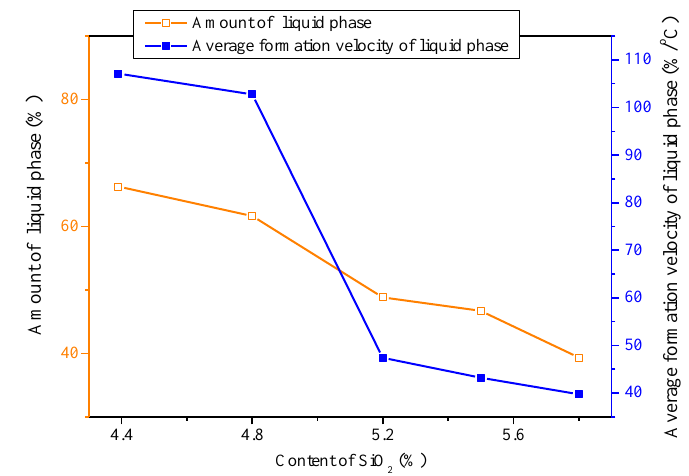
Figure 13. Influence of SiO 2 content on the amount and generation velocity of the liquid phase.